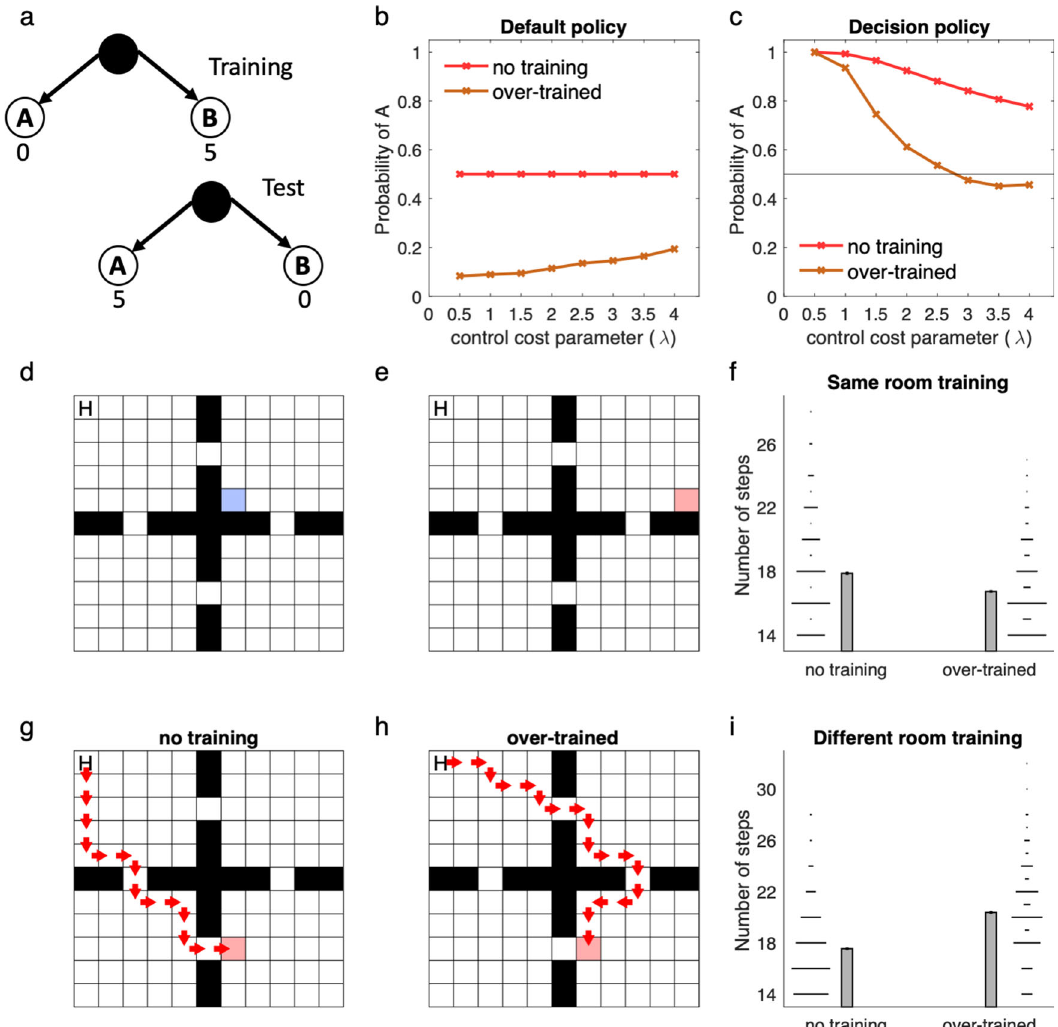
Fig. 7 Learning the default policy results in soft habits. a – c A simple choice task ( a ) in which the default policy has been extensively trained under conditions in which state B is rewarding. In this case, an overtrained default policy favors choice of B by default ( b ) which softly biases choice away from A even after the rewarded goal has moved in the test phase ( c ). This effect is larger when the control cost parameter, λ , is larger. This is because this parameter controls the relative weight of the control cost (for diverging from default policy; see “ Methods ” , Eq. (6)). d The default policy has been trained extensively to fi nd a goal located in the blue square. e , f Performance of the model with overtrained vs. uniform (i.e. no training) default policies on this task, in which the goal has been moved but it is still in the same room ( e ). The overtrained model performs better here ( f ). However, when the goal has been moved to a different room ( g – i ), the model with a uniform default policy (no training; g ) performs better than the overtrained model, which habitually enters the room in which it has been overtrained in ( h ). Mean, standard error of the mean, and distribution of data across 1000 simulations are plotted in panels f and i . For overtraining, the model has experienced 1000 episodes of the task with step-size 0.01. Source data are provided as a Source Data fi